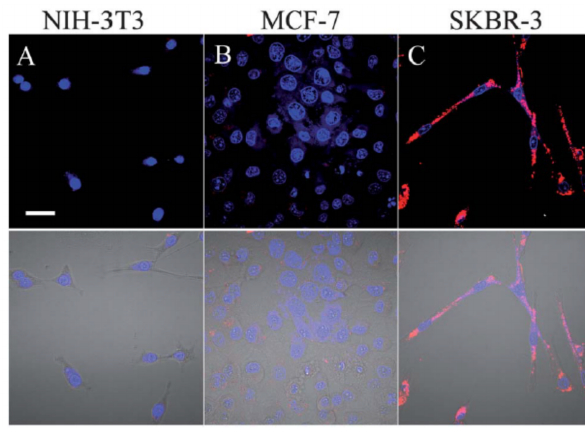
Figure 11. CLSM fluorescence (top) and fluorescence/transmission overlay (bottom) images of fixed NIH-3T3 ( A ); MCF-7 ( B ) and SKBR-3 ( C ) cells incubated overnight with 5 nM CPNP 15 at 37 ◦ C. All images share the same scale bar of 30 µ m. Reproduced with permission [45]. Copyright: 2013, Royal Society of